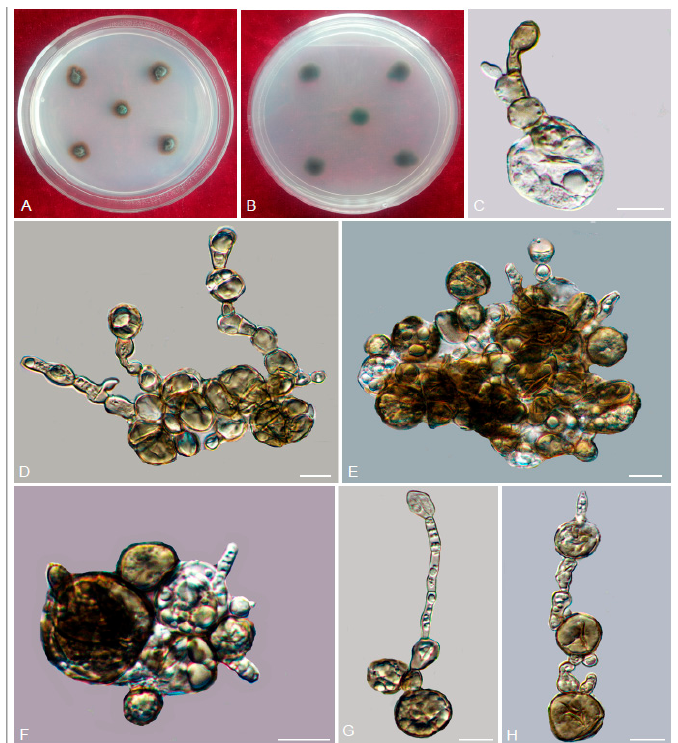
Figure 8. Bradymyces pullus (CGMCC 3.17305). ( A , B ) Colony forward and reverse after 20 weeks on MEA. ( C , E , F ) Solitary, enlarged, darkly pigmented multicellular bodies. ( D ) Moniliform hyphae with a mass of di ff erentiated blastic proliferating hyphae. ( G,H ) Terminal and intercalary swollen cells. Scale bars: ( C – H ) = 10 µ